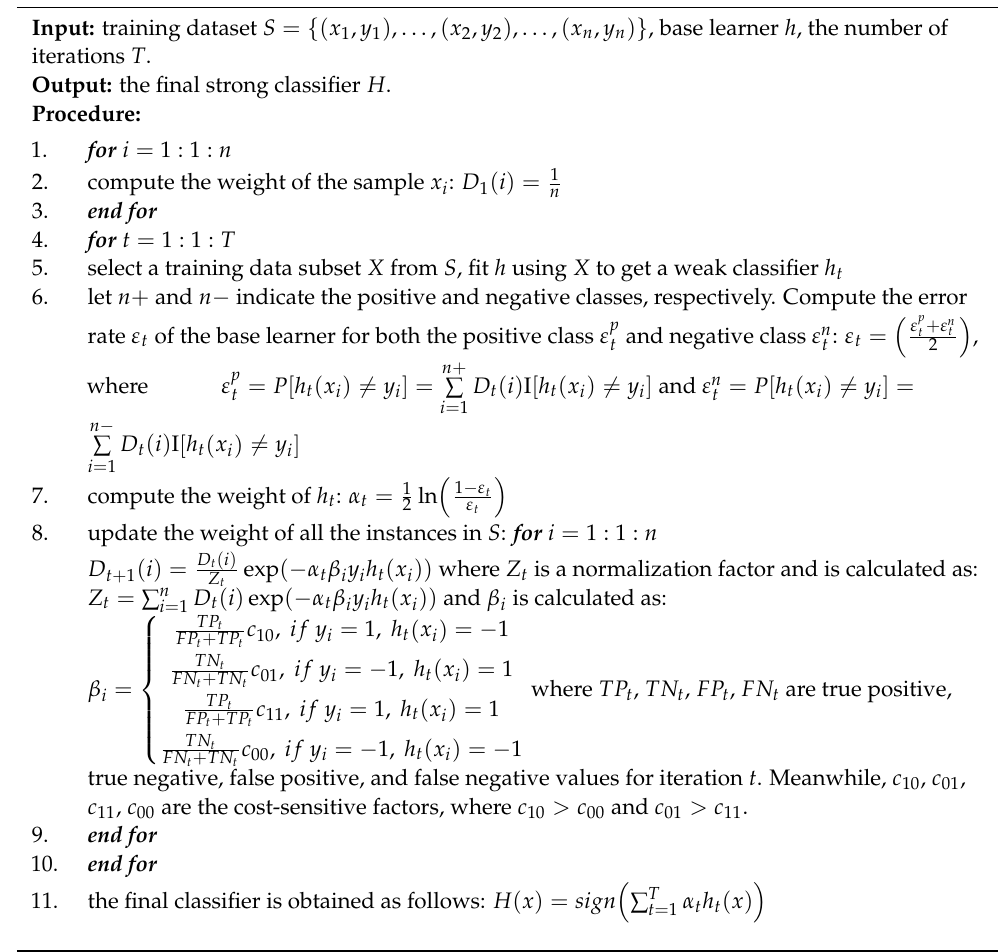
Algorithm 2: Cost-Sensitive